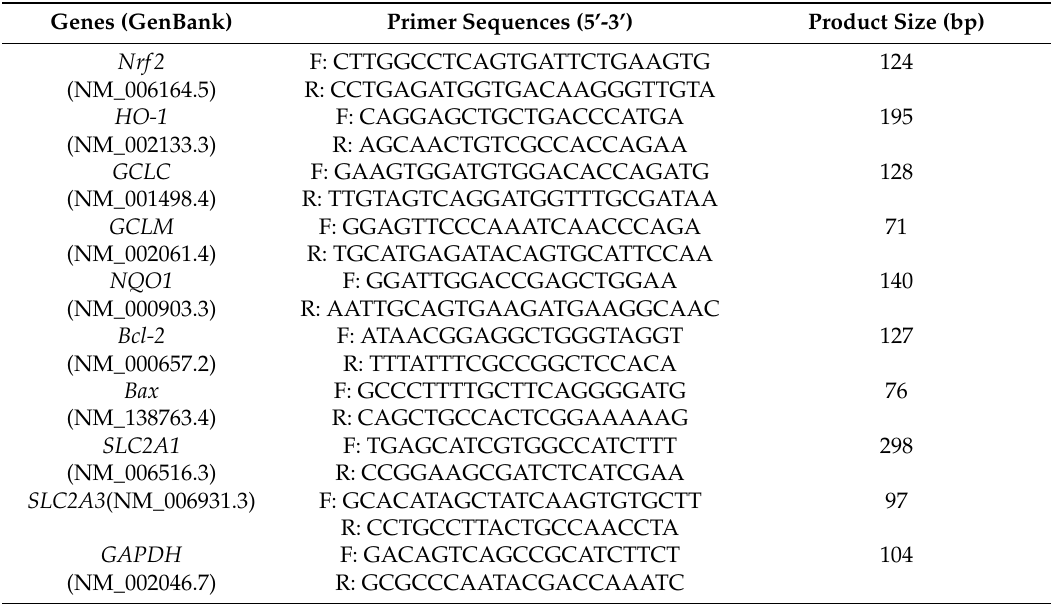
Table 1. The primer sequences for real-time